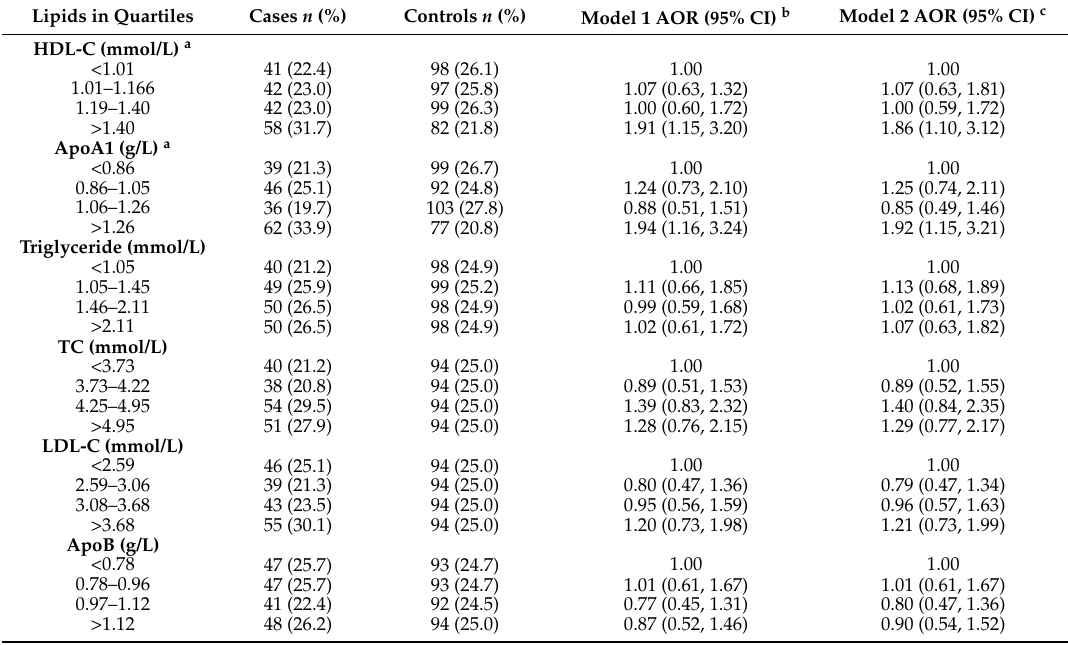
Table 5. Association of altered maternal HDL-C and apoA1 with spontaneous preterm delivery: comparing the lowest quartile to other